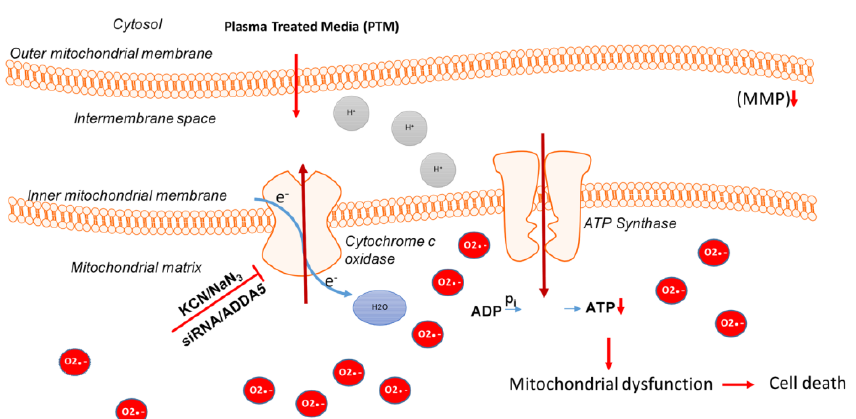
Figure 8. Inhibition of cytochrome C oxidase and the addition of PTS (fully supplemented cell culture medium, kINPen argon plasma jet) leads to an increase in superoxide anions (red) in the mitochondrial matrix that results in loss of MMP and subsequent ATP depletion. This finally leads to an energy crisis and cell death. Reproduced from [74]. Copyright 2018 Springer Nature.